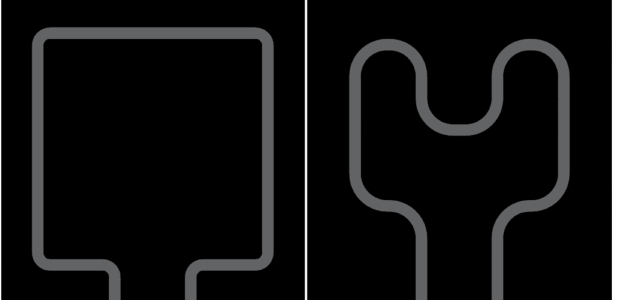
Figure 2. Top view of a section of half plate for the common configuration for cooling systems: square ( left ) and fork ( right ) shapes of channels.